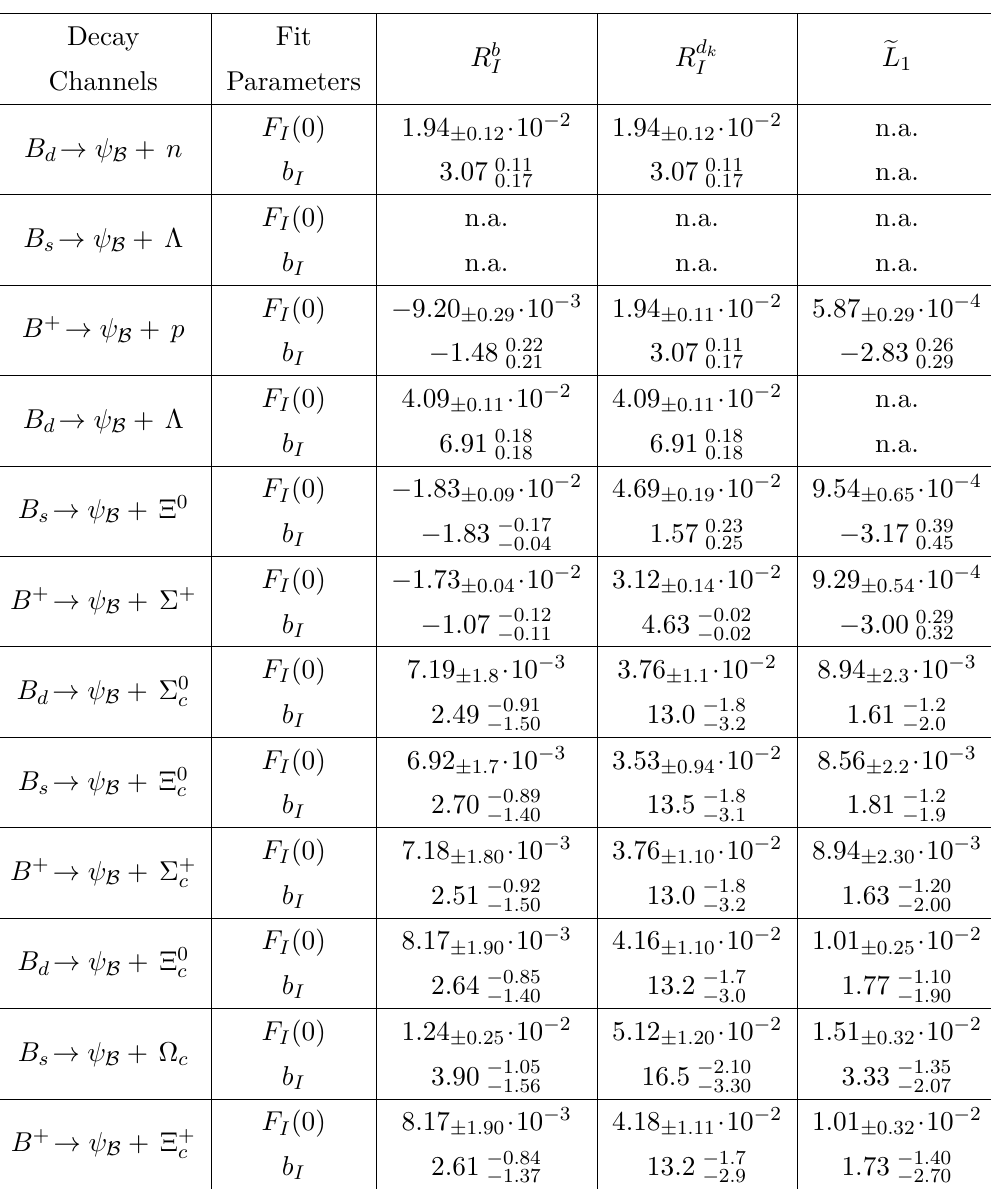
Table 3 . Fit parameters for the different decay